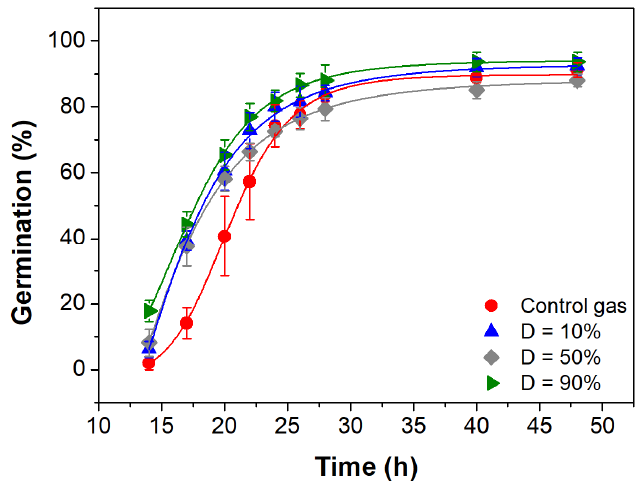
Figure 8. Germination acceleration of treated rapeseed (3 min) using different duty cycles. Germination curves were fitted with the Hill function.